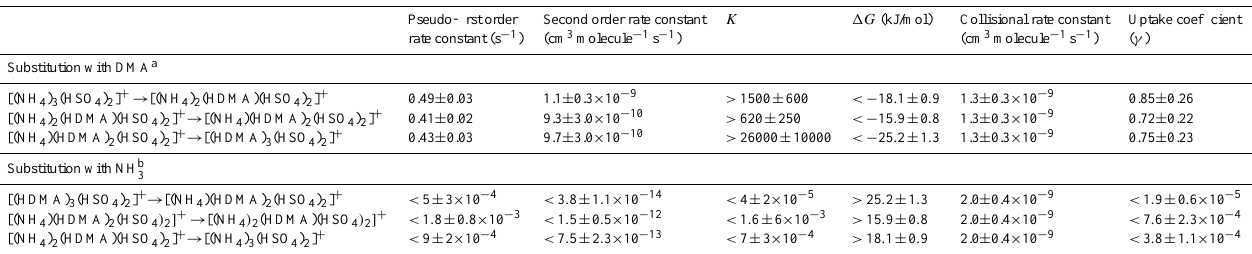
Table 1. Data summary for the substitution of DMA for NH 3 in the 3–2 ammonium bisulfate cluster and for the substitution of NH 3 for DMA in the 3–2 dimethylaminium bisulfate